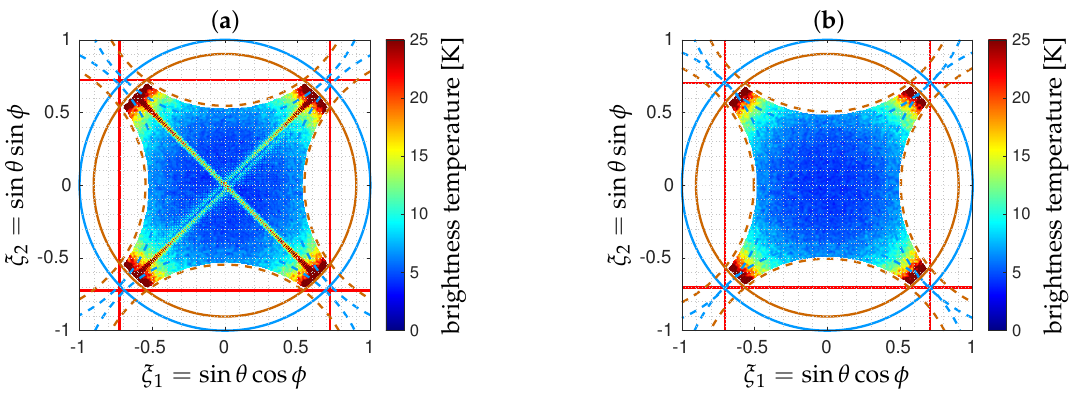
Figure 11. Standard deviation maps of 1000 error maps (cid:101) T − T obtained in X polarization with the cross-shaped array shown in Figure 4 for two values of the shortest spacing: ( a ) d = 0.69 λ and ( b ) d = 0.71 λ (similar results are obtained in Y polarization). In every case, complex visibilities V have been blurred by an additive Gaussian noise ∆ V with standard deviation set to 0.1